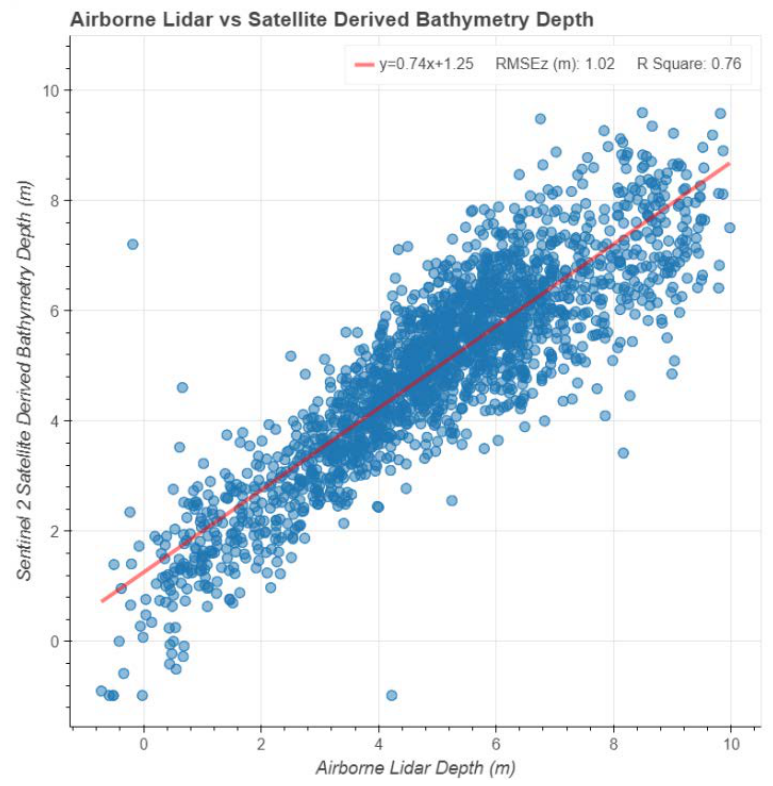
Figure 22. Plot comparison of SDB generated from Sentinel-2 imagery to airborne bathymetric lidar point cloud (30 cm vertical accuracy).